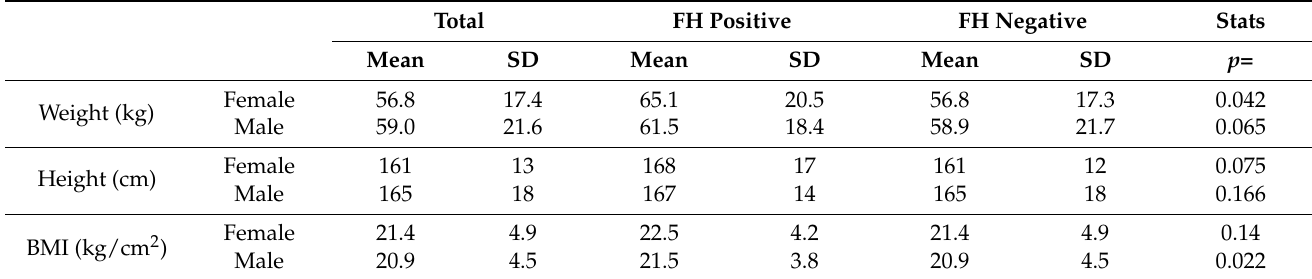
Table 2. Differences in weight, height, and BMI between the FH+ and FH- groups, stratified by gender. The table presents the mean and standard deviation (SD) of weight (in kg), height (in cm), and body mass index (BMI, in kg/cm 2 ) for the total study population, the FH+ group, and the FH- group, separated by gender. The p -values in the rightmost column indicate the statistical significance of the differences between the FH+ and FH- groups, assessed using the non-parametric Mann–Whitney U test.